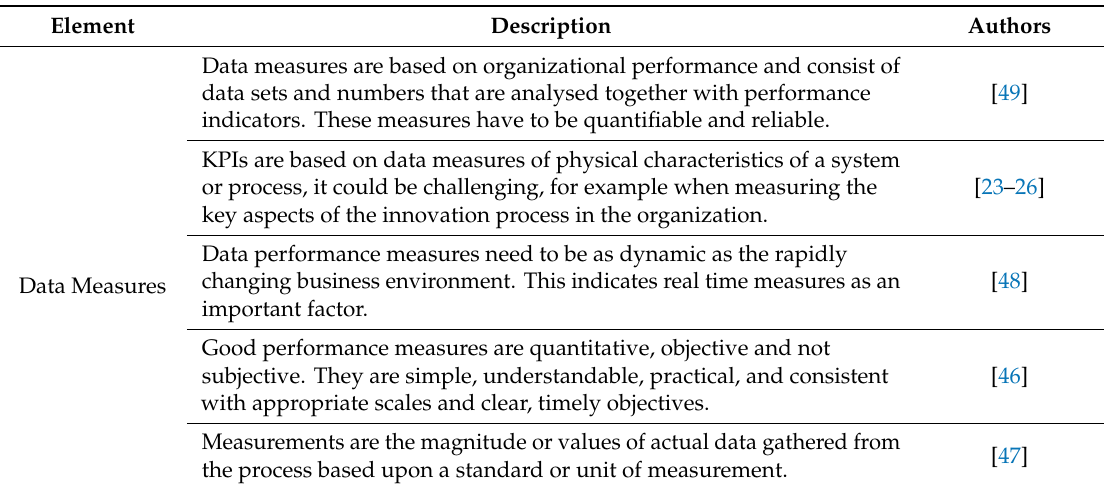
Table 3. The term, data measures, used in relation to organizational